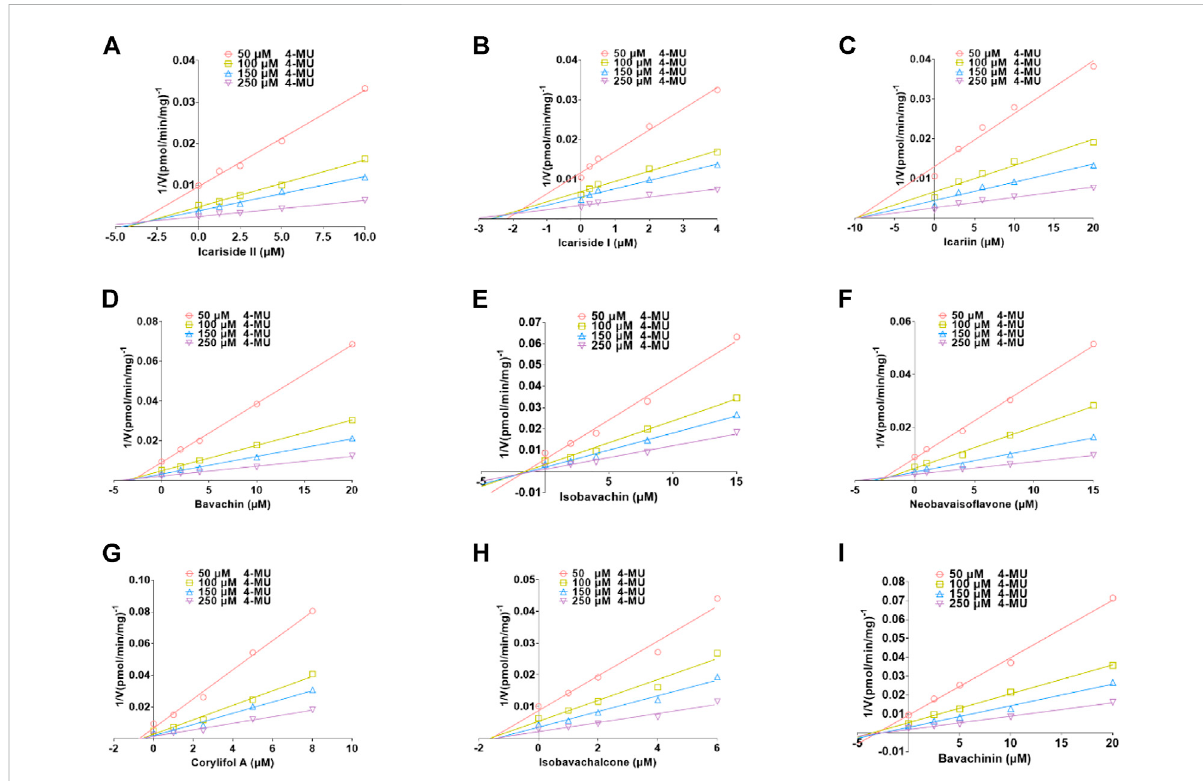
FIGURE 4 Dixon plots for inhibitory effects of icariside II (A) , icariside I (B) , icariin (C) , bavachin (D) , isobavachin (E) , neobavaiso fl avone (F) , corylifol A (G) , isobavachalcone (H) , and bavachinin (I) toward 4-methylumbelliferone- O -glucuronidation for UGT1A10. All data were performed in triplicate (mean ±